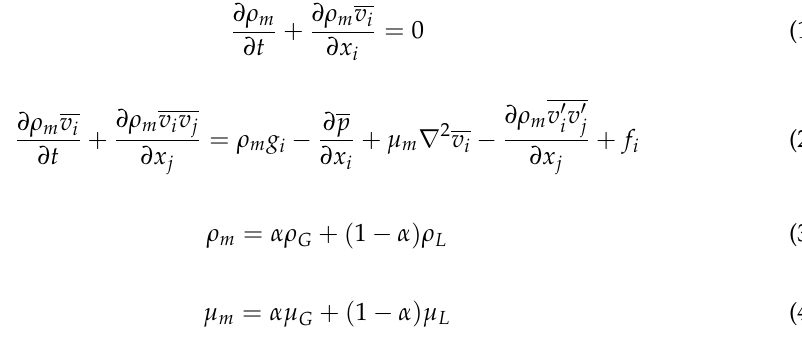
Figure 3. The fundamental modal shapes in both in-plane and out-of-plane directions obtained via modal analysis, where f x1 , f z1 and f y1 denote the fundamental natural frequencies in x, z and y direc- tions, respectively.